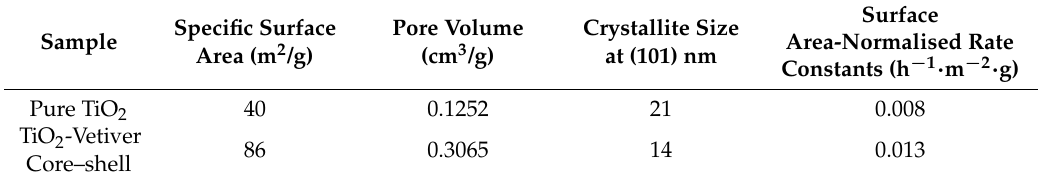
Figure 9. The schematic representation of the photocatalytic mechanism. Table 1. BET data for surface properties of pure TiO 2 and TiO 2 ‐ vetiver core–shell.